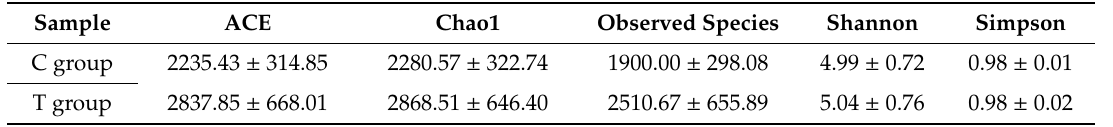
Table 1. Ecological indexes of Alpha diversity.